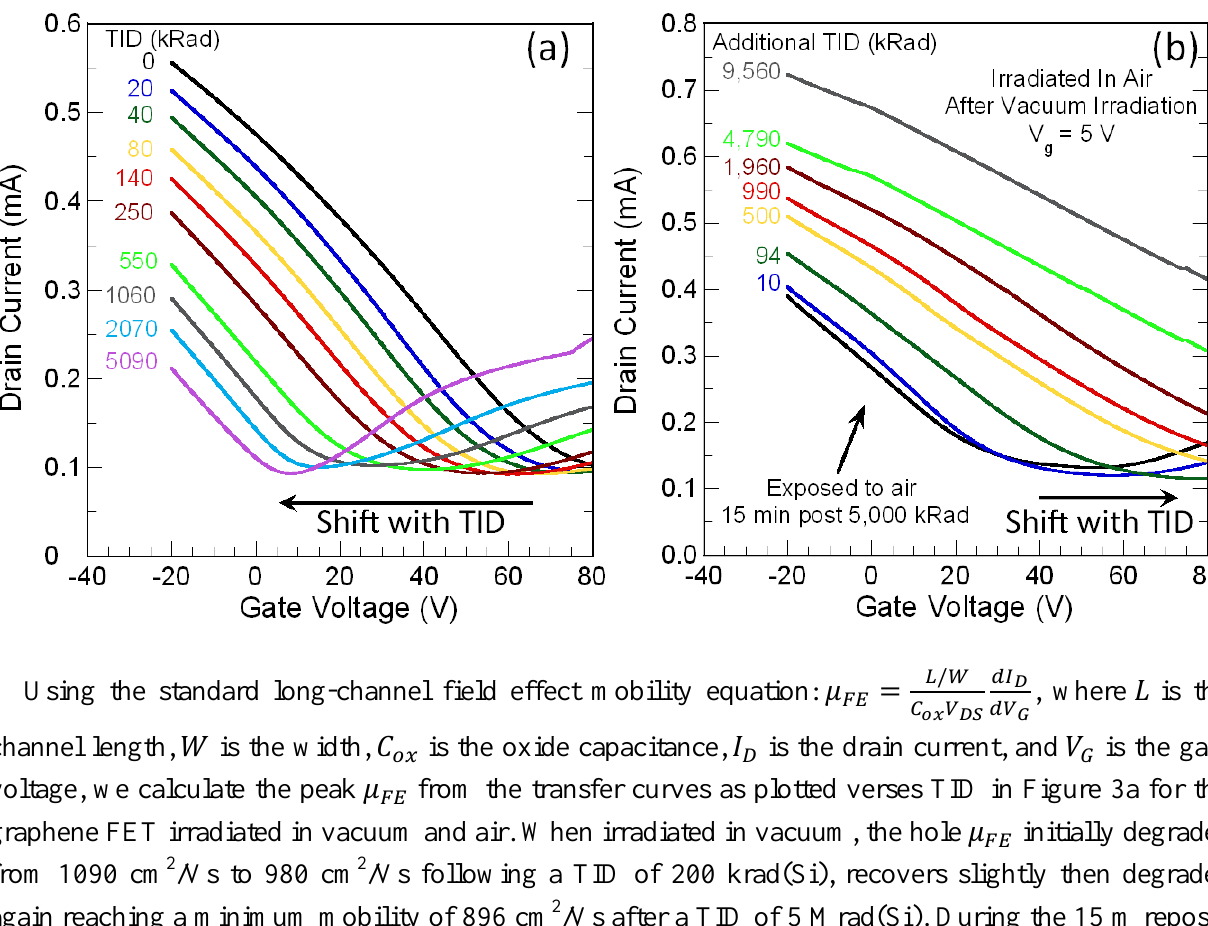
Figure 2. ( a ) Transfer characteristics of a back-gated graphene-FET with incremental total ionizing dose; ( b ) Transfer characteristics of the same device following 15 min of air exposure (black curve) and with additional total ionizing dose